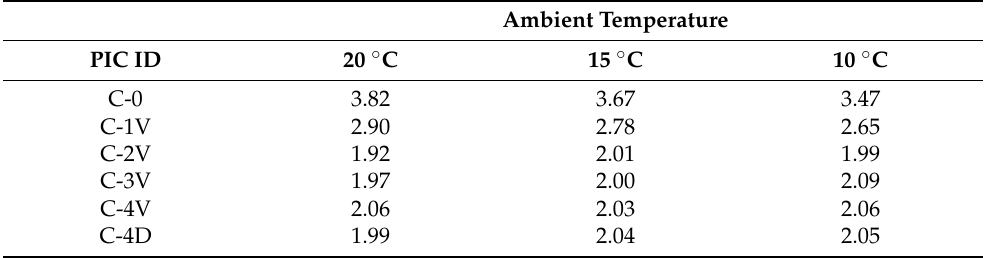
Table 3. The ratios of maximum activated and nonactivated